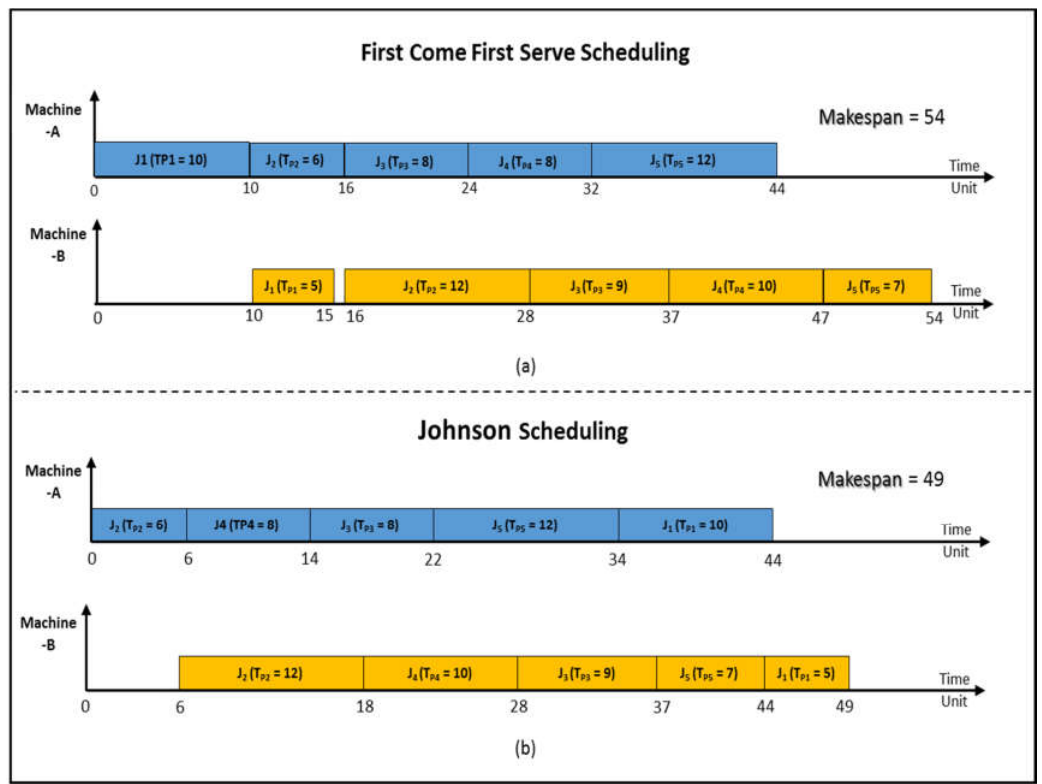
Figure 2. ( a ) First Come First Serve Scheduling Gantt chart; ( b ) Johnson Scheduling Gantt chart.